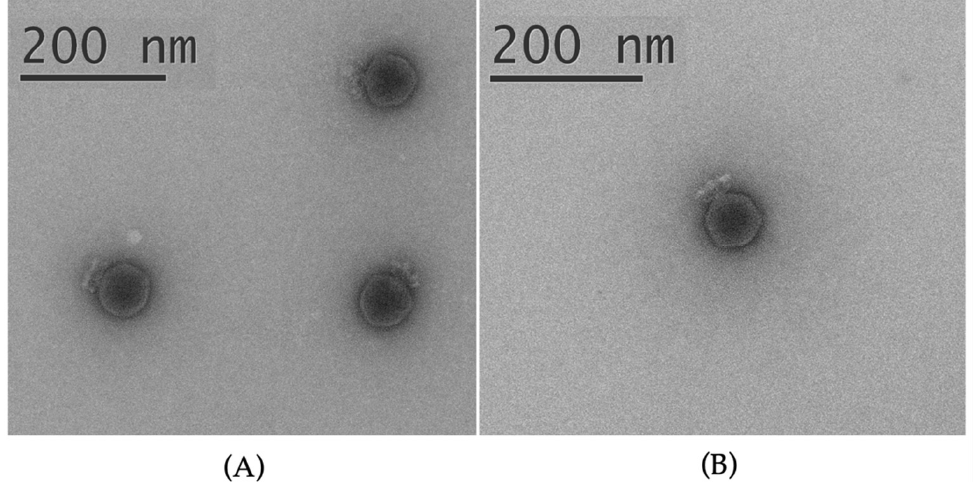
Figure 1. Electron micrograph of the virions of phages Possum ( A ) and Horatius ( B ). Specimens were stained with 1% uranyl acetate.